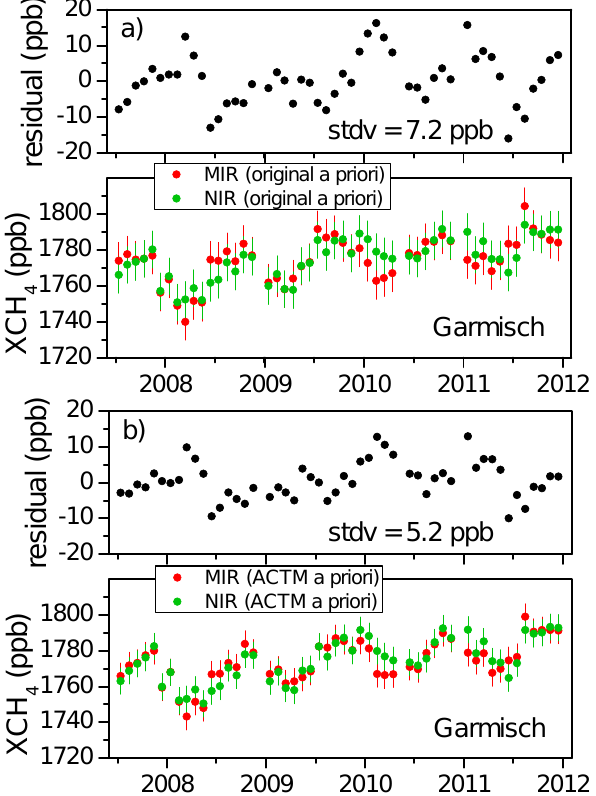
Fig. 5. (a) Lower trace: monthly mean MIR and NIR time series for Garmisch. Both column series are plotted as retrieved; i.e. no cor- rection for a priori impact according to Eq. (1) has been performed. Error bars are 2- σ uncertainites as explained in Fig. 4. Upper trace: residual time series, i.e. difference time series of the NIR and MIR data shown in the lower trace. (b) Same as (a) but using ACTM profiles as common prior.